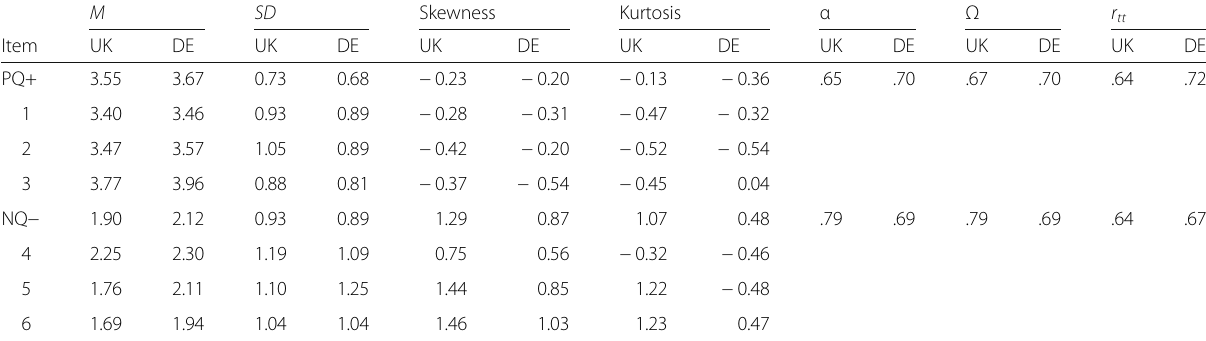
Table 3 Descriptive statistics for KSE-G items and subscales M SD